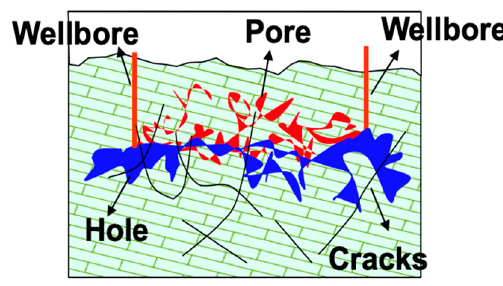
Figure 1. Spatial structure model of Tahe reservoir.